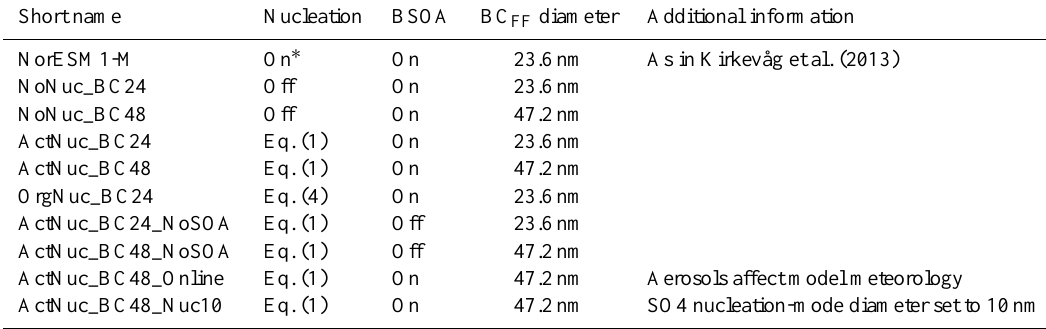
Table 1. Simulated sensitivity experiments. The simulated climate is identical in all experiments except ActNuc_BC48_Online, where aerosol–climate interactions are switched